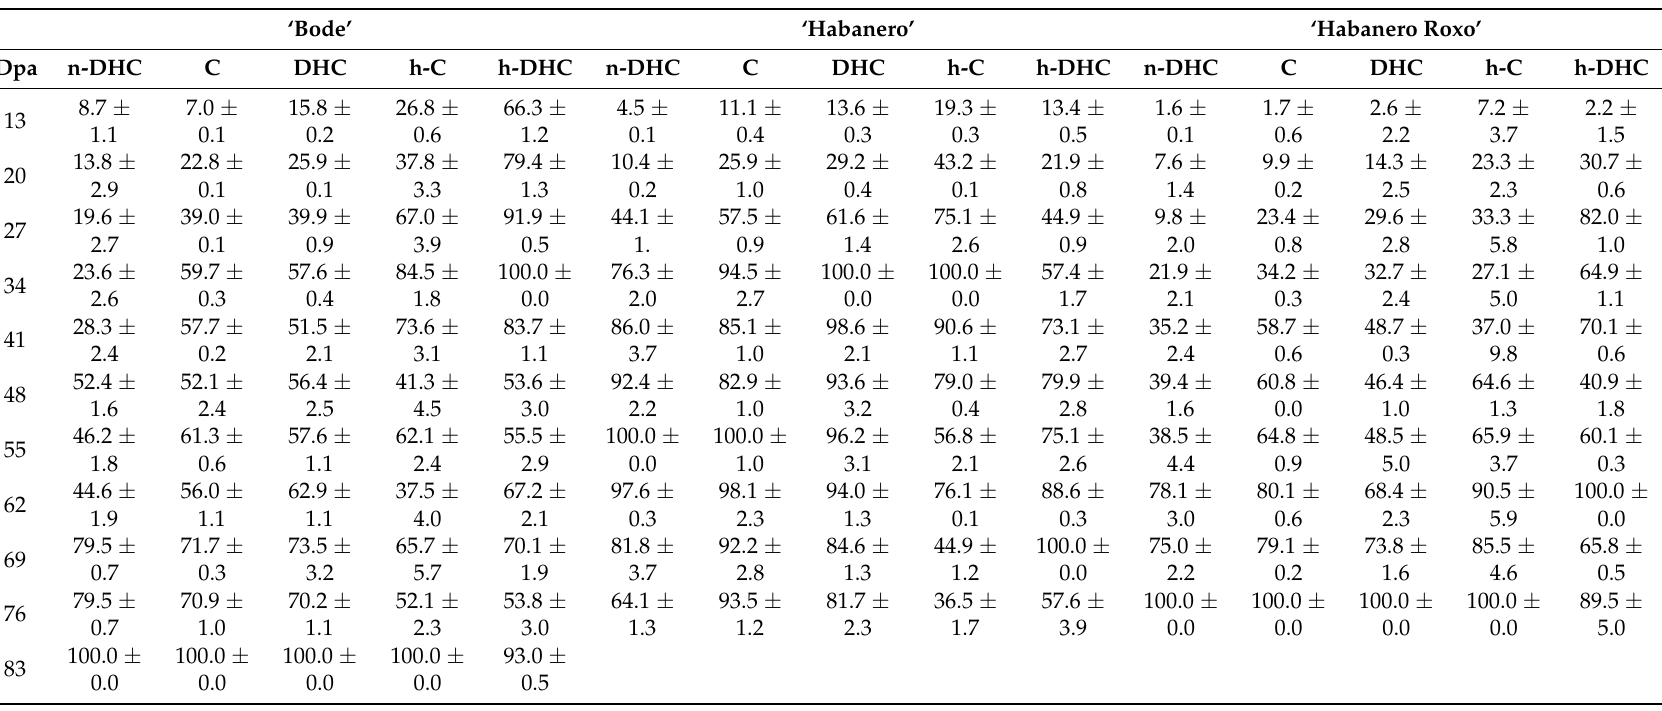
Relative percentages (standardized values) of individual capsaicinoids (nordihydrocapsaicin (n-DHC), capsaicin (C), dihydrocapsaicin (DHC), homocapsaicin (h-C), and homodihydrocapsaicin h-DHC)) in Capsicum chinense cultivars during pepper fruit ripening. Results are presented as mean ± SD ( n = 3). Different letters in the same column indicate statistically significant differences between groups ( p < 0.05). The development stages of pepper fruits were measured as days post-anthesis